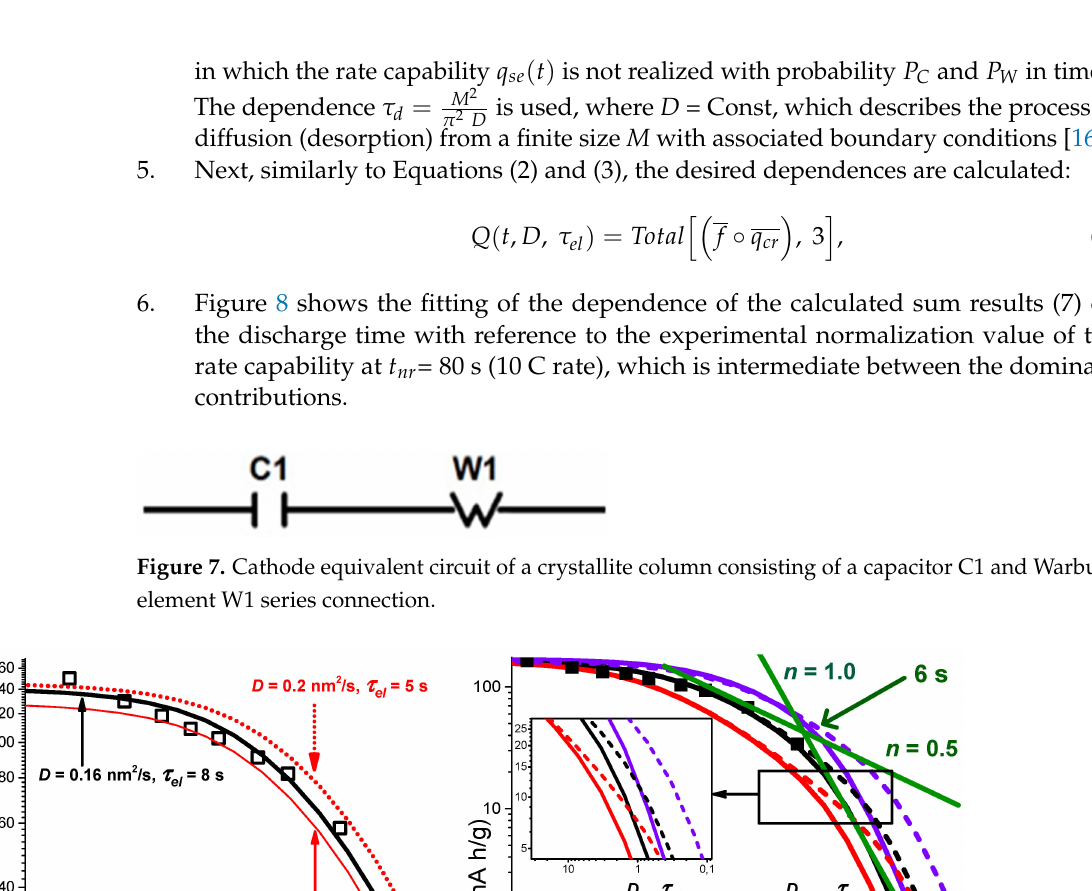
Figure 8. ( a ) Theoretical Q ( t , D , τ el ) dependence, Equation (8), on the discharge time for the de- veloped powder with the steps of fitting the most optimal black curve to the experimental points. ( b ) The same optimal curve and experimental points on large scales along the axes and large values of D and τ el to demonstrate tilt angles. Straight lines with slopes n corresponding to the Warburg element and capacitor are shown, with the intersection at the point t = 6 s close to the obtained value τ el = 8